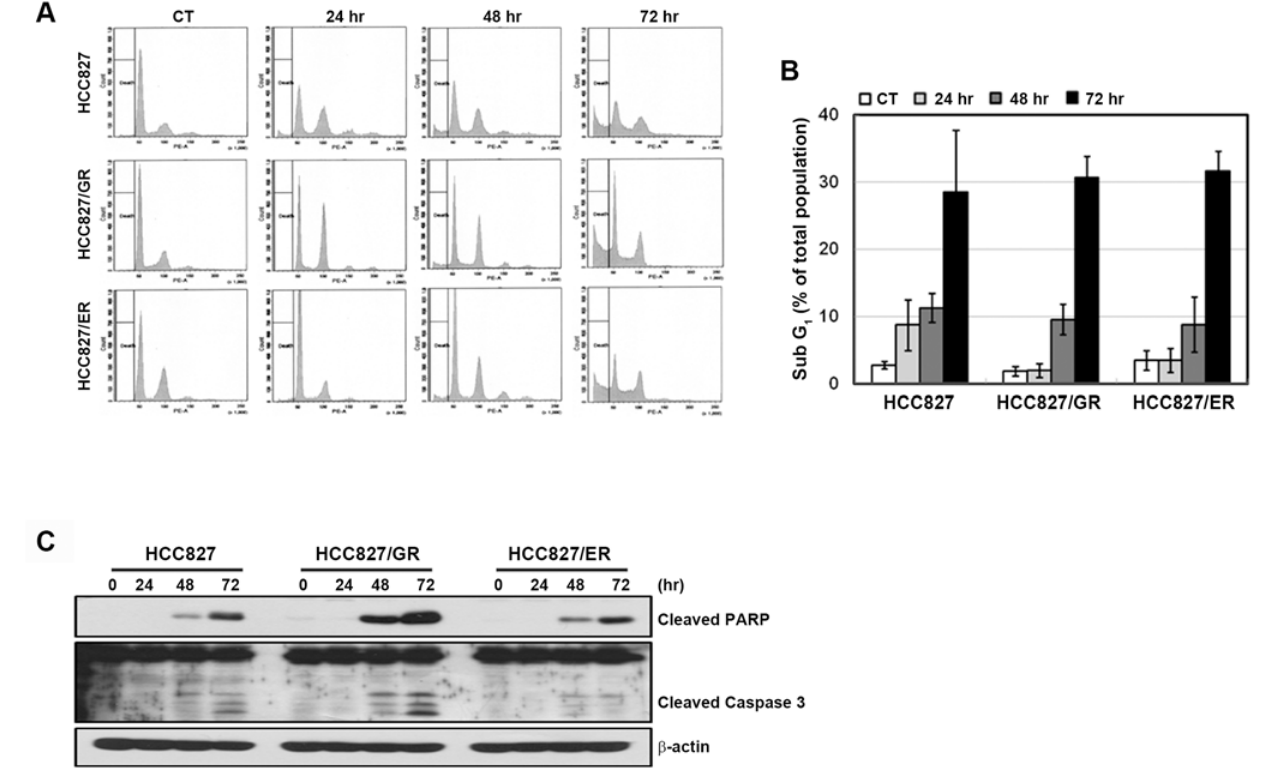
Fig 3. Induction of cell death in response to AUY922. A and B , Cells were treated with 0.1 μ mol/L AUY922 for 24 – 72 hours. To analyze the cell cycle distribution, the harvested cells were analyzed by flow cytometry. C , Cell lysates were analyzed using western blotting. The indicated antibodies were used to evaluate apoptotic cell